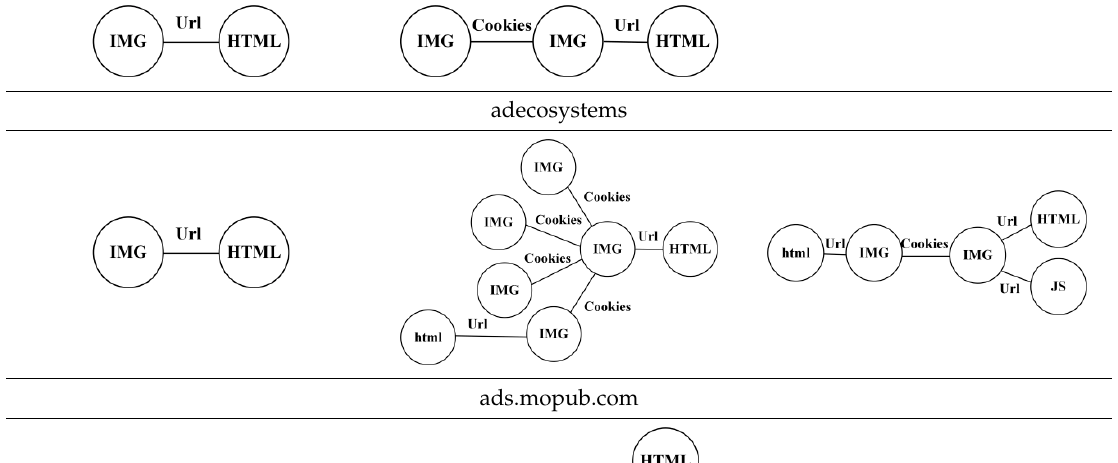
Table 1. Advertising behavior graphs of ad libs (with ad lib as index). Figure 5. Ad libs’ network behaviors and their graph representations ( a ) MoPub, ( b ) Mmate, ( c ) Hap-game, ( d ) Millennial Media, ( e ) AppLovin.